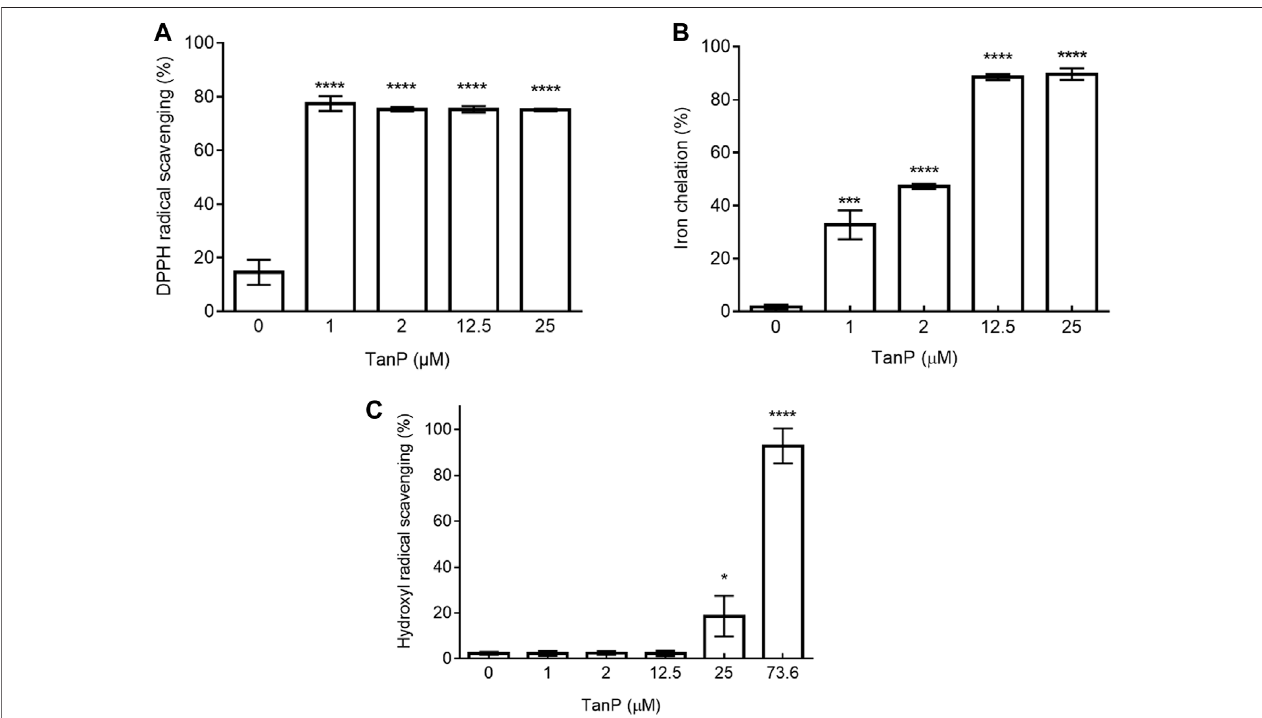
FIGURE 4 | Evaluation of antioxidant activity of TanP. (A) DPPH radical scavenging capacity. DPPH solution (150 µM) was used as a control. (B) Iron chelation capacity. EDTA (0.1 mg/ml) was used as a control. (C) Hydroxyl radical scavenging activity of TanP. Gallic acid (0.25 – 2 mg/ml) was used as the control. Statistical signi fi cancewasperformedusingANOVAfollowedbyTukey ’ stestandexpressedasmean ± SD(n (cid:2) 3).* p < 0.05,** p < 0.01,*** p < 0.001,and ****p < 0.0001compared with the control